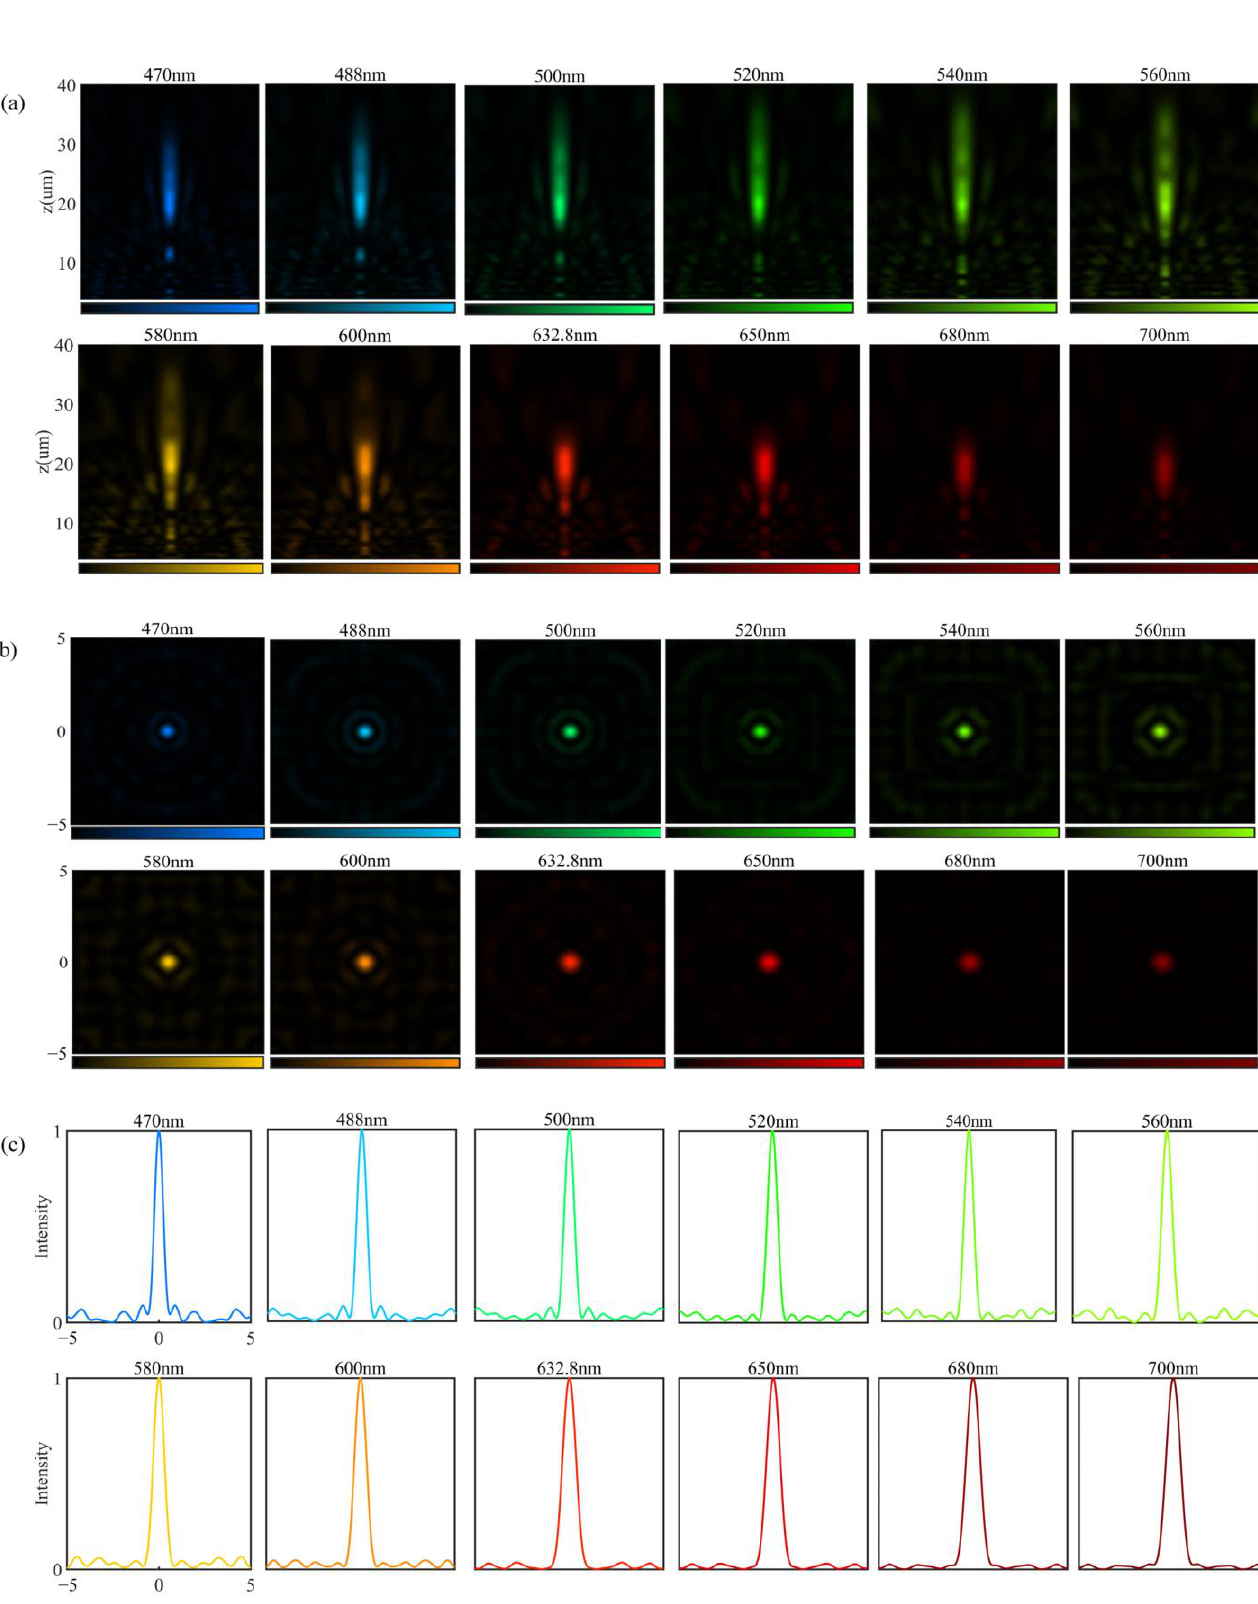
Figure 6. ( a ) Normalized intensity distributions in the x-z plane of different wavelengths; ( b ) nor- malized intensity distributions of focal spots in the x-y plane of different wavelengths; ( c ) the corresponding cross-sectional intensity cut through the focal planes of different wavelengths.